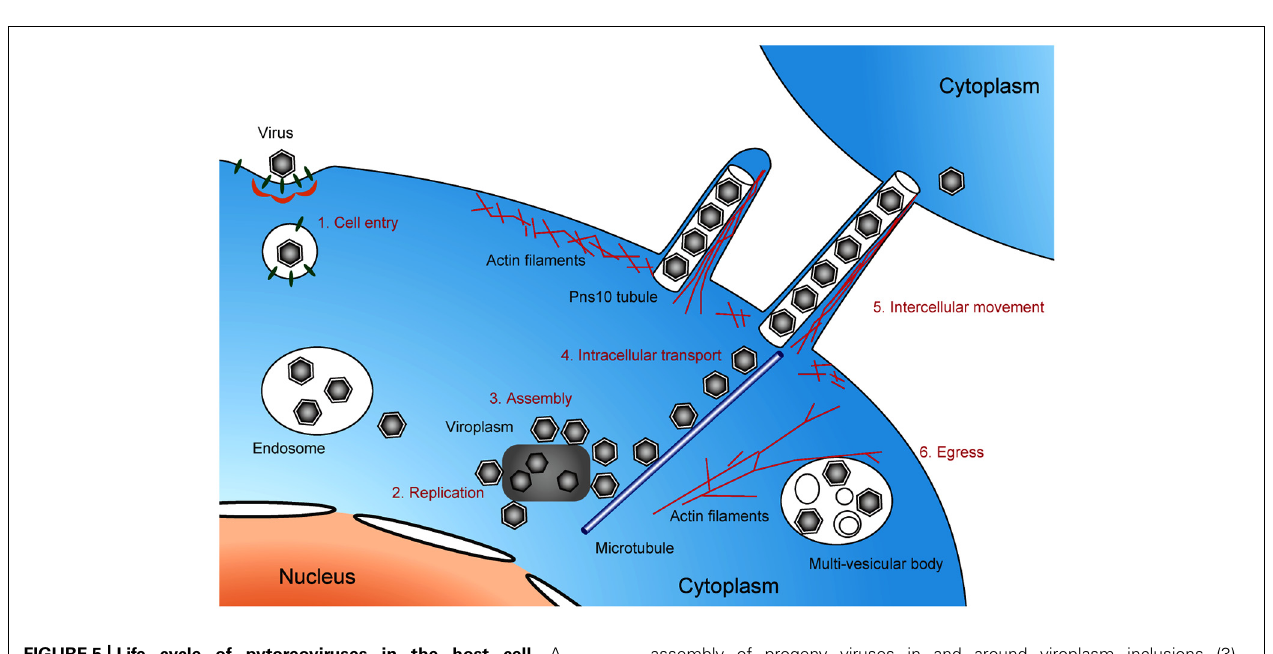
assembly of progeny viruses in and around viroplasm inclusions (3), microtubule-associated intracellular transport (4), intercellular movement exploiting Pns10 tubule (5), and viral egress via multi-vesicular bodies